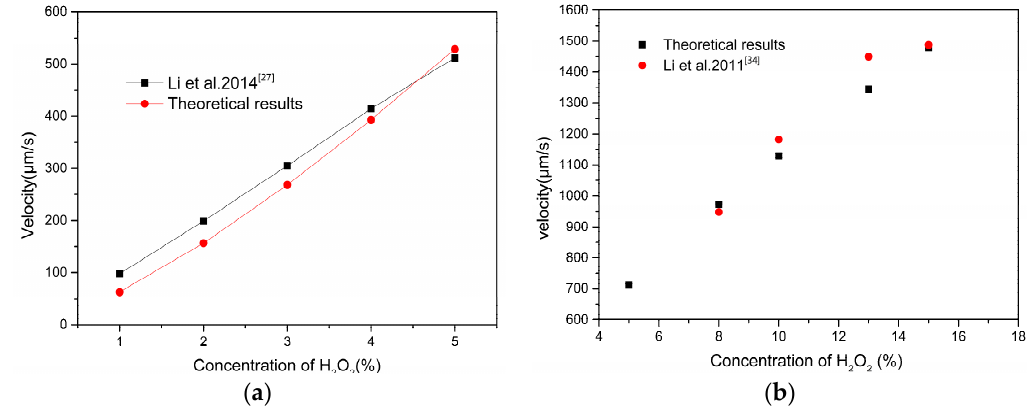
Figure 3. The velocity of micromotor versus H 2 O 2 concentration: ( a ) at low concentration (<5%) with length L = 9.1 μ m, (cid:1844) (cid:3040)(cid:3028)(cid:3051) = 1.16 μ m, δ = 2.3°, CH 2 O 2 = 1–5%; and ( b ) at high concentration (>5%) with length L = 100 μ m, (cid:1844) (cid:3040)(cid:3028)(cid:3051) = 10 μ m, δ = 0°, CH 2 O 2 = 5–15%.